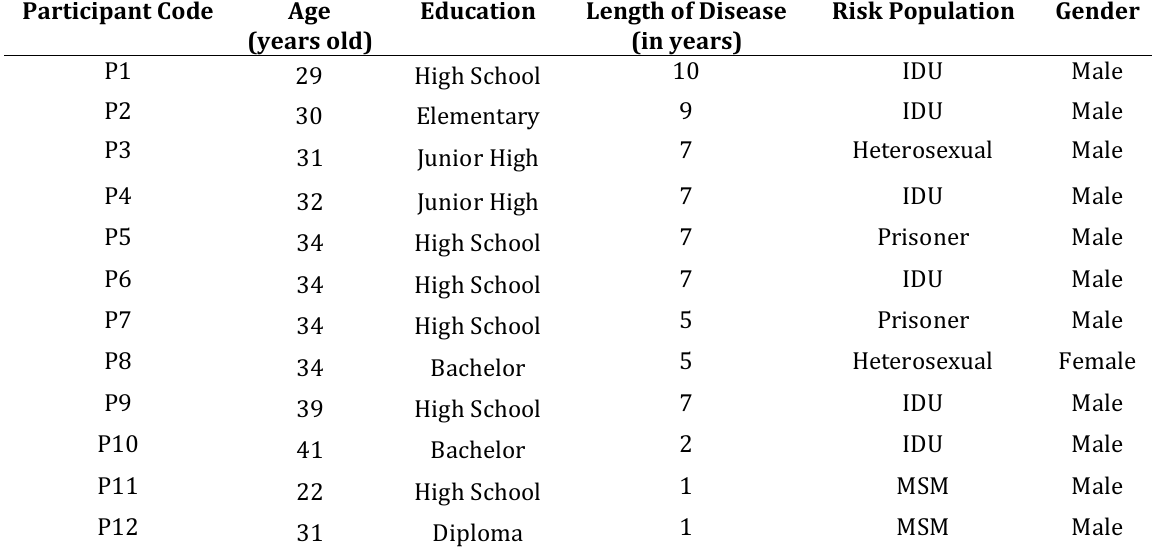
Table 1. Participant Characteristic Participant